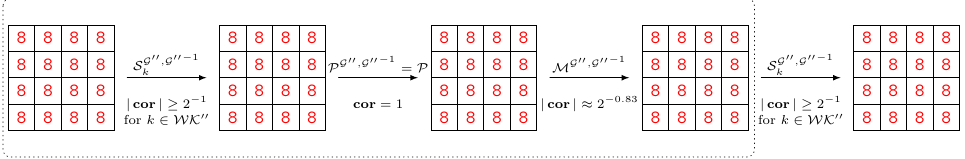
Table 1: Fixing the second round key k 1 = ( 0 , 0 , 0 , 0 ), this table shows all possible values for the absolute correlation of the approximation ( 8 , 8 , 8 , 8 ) → ( 8 , 8 , 8 , 8 ) over E G 00 , G for k 0 from the set of weak keys WK 00